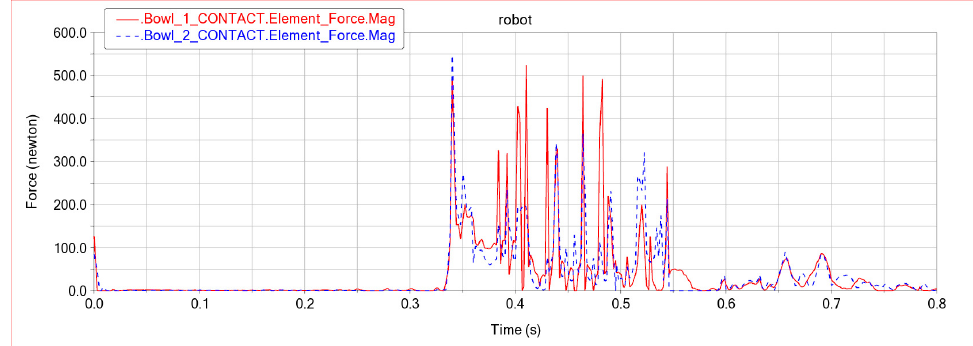
Figure 13. Variation of the bowl’s force with time in crossing the bend.